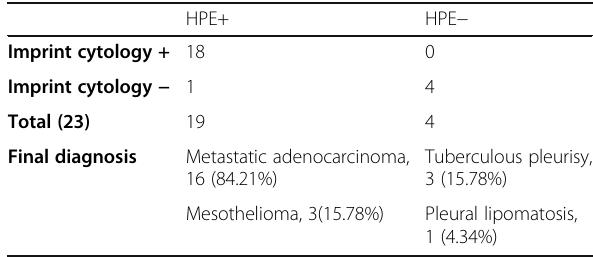
Table 6 Imprint and histopathological examination (HPE) in the thoracoscopic